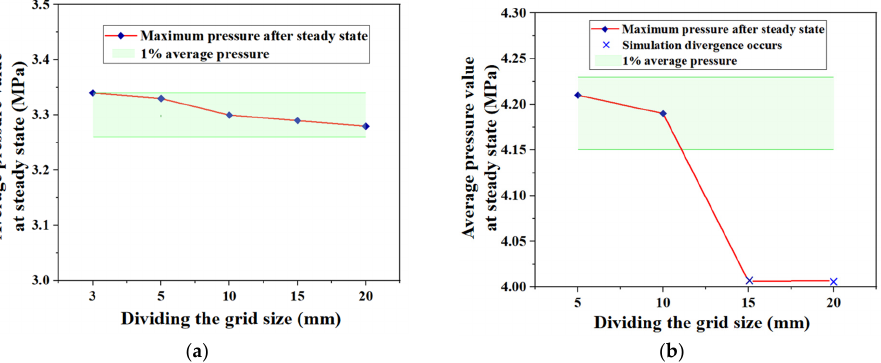
Figure 5. The grid delineation quality independent study: ( a ) relationship between maximum pressure and mesh size for oil erosion; ( b ) relationship between maximum pressure and mesh size for seawater erosion.